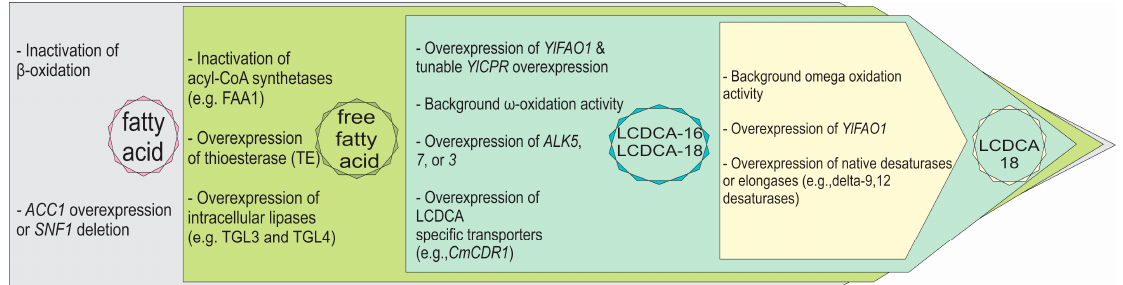
Figure 9. Summary of elements for further improvement.